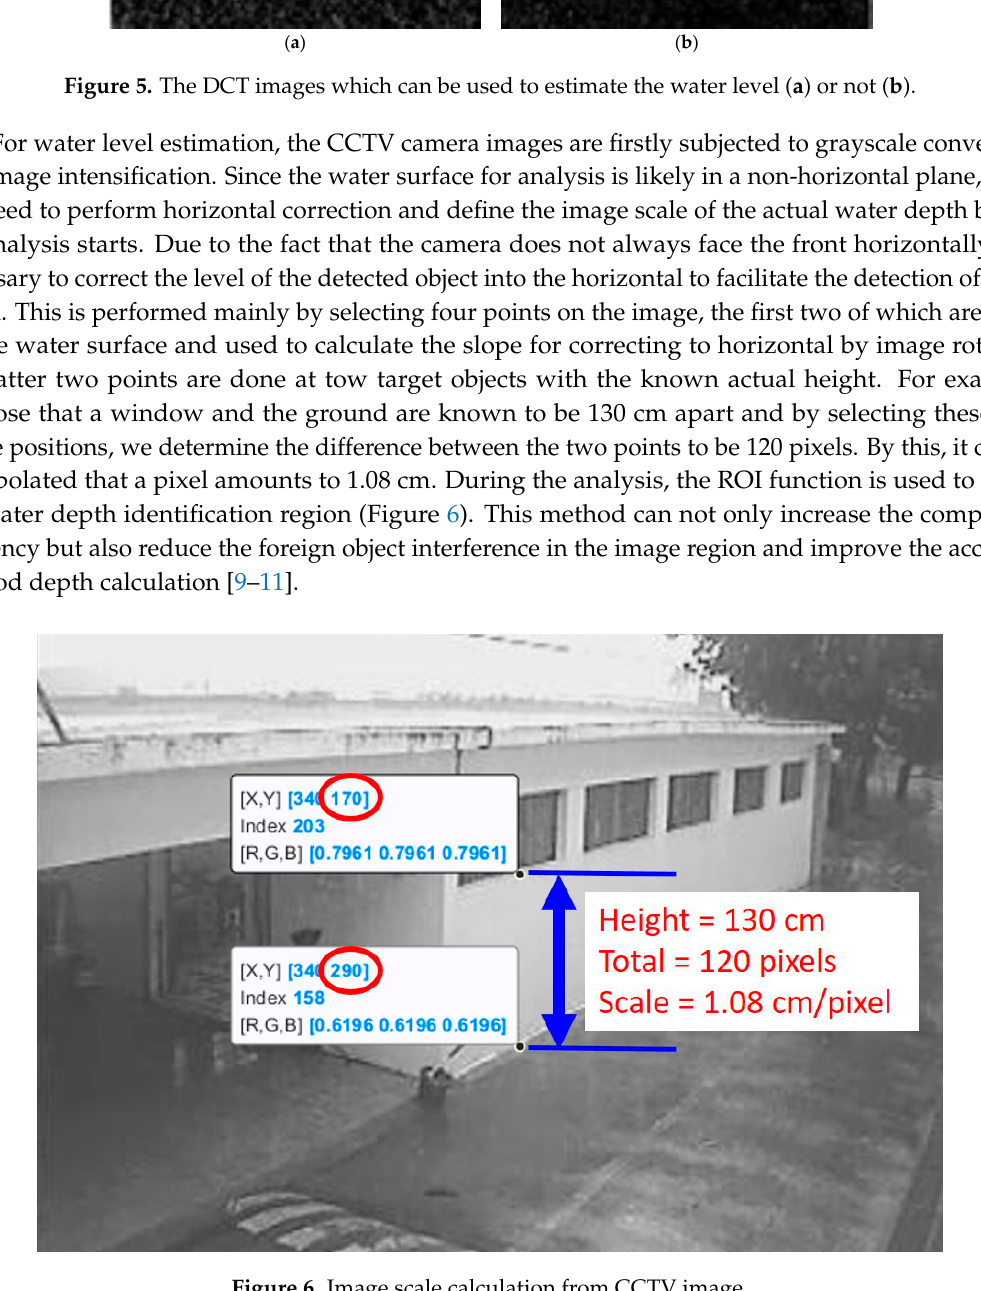
Figure 6. Image scale calculation from CCTV image.